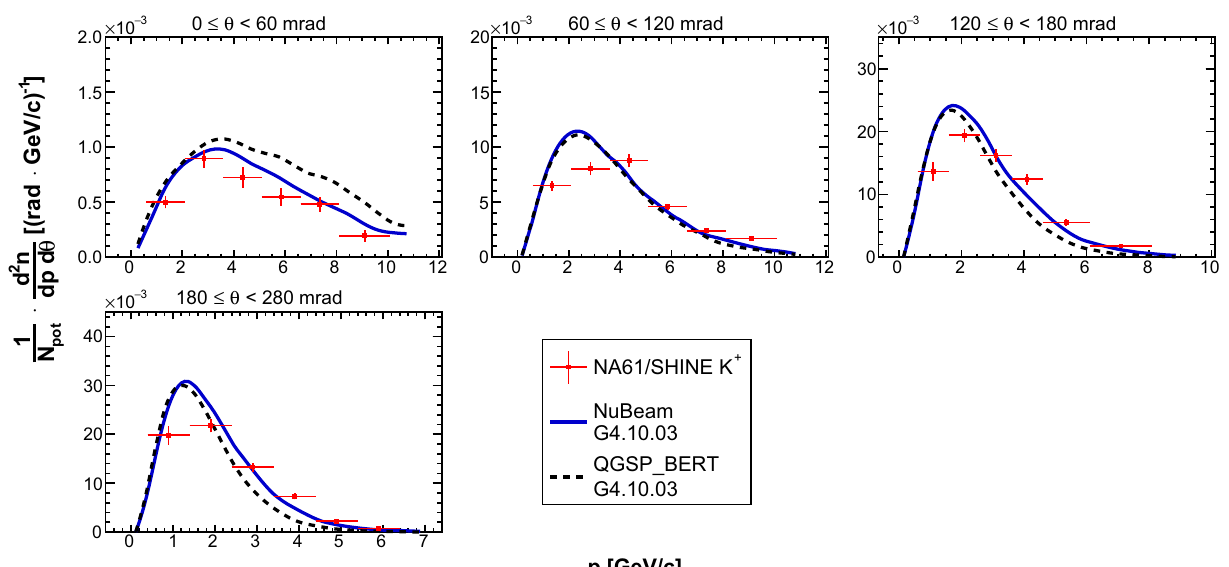
Fig. 35 Double differential yields of positively charged kaons for the mostupstreamlongitudinalbin(0 ≤ z < 18cm).Verticalbarsrepresent the total uncertanties. Predictions from the NuBeam (solid blue line)